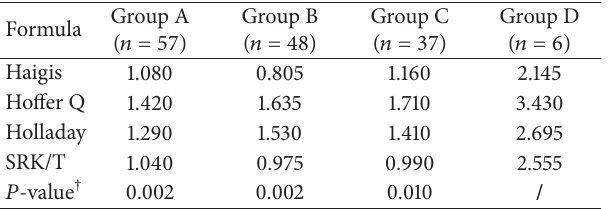
Table 4: Median absolute errors (D) calculated by each formula for Groups